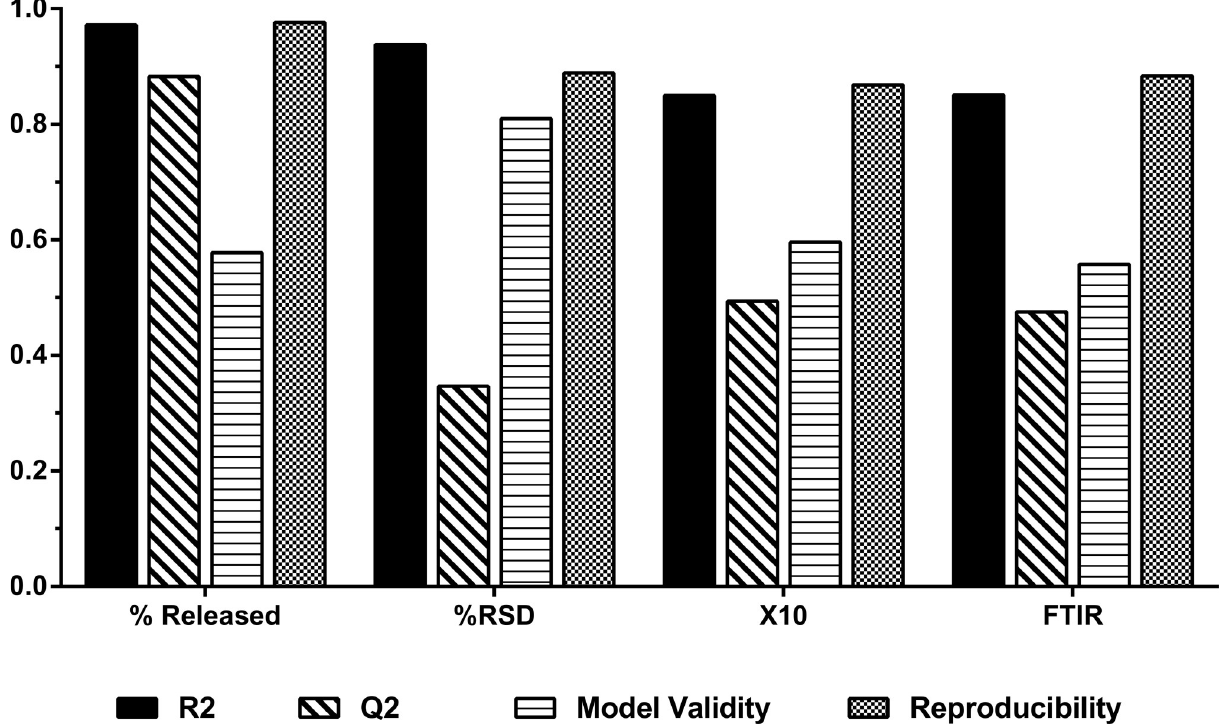
Fig 6. Summary plot of the four responses (CQAs) of fit showing model Fit (R2), predictability (Q2), model validity and reproducibility. Model fitted with PLS.